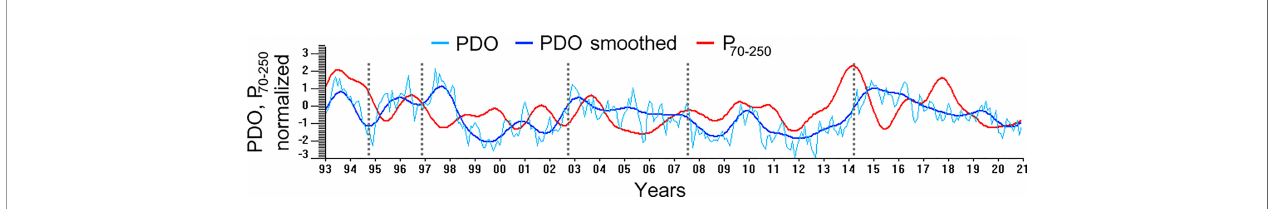
FIGURE 6 | The low-pass fi ltered, with the cut-off period of 1.5 year, timeseries of (red line) P 70 – 250 and (blue line) PDO index; the original PDO index is shown for comparison by light-blue line. The vertical grey dashed lines separate the times with different character of the relationship between PDO and P 70 – 250